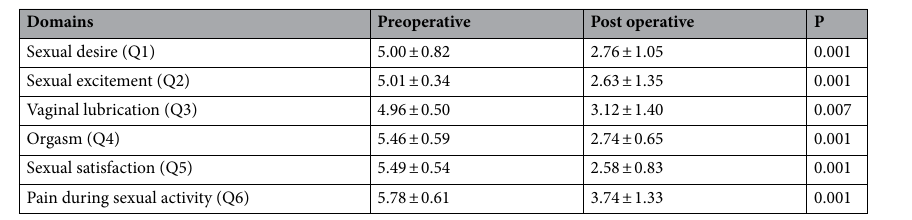
Table 4. Comparative analysis of female sexual function scores (mean ± standard deviation of mean) of the Female Sexual Function Index domains, before and after splenectomy. P significance related to paired t-test.